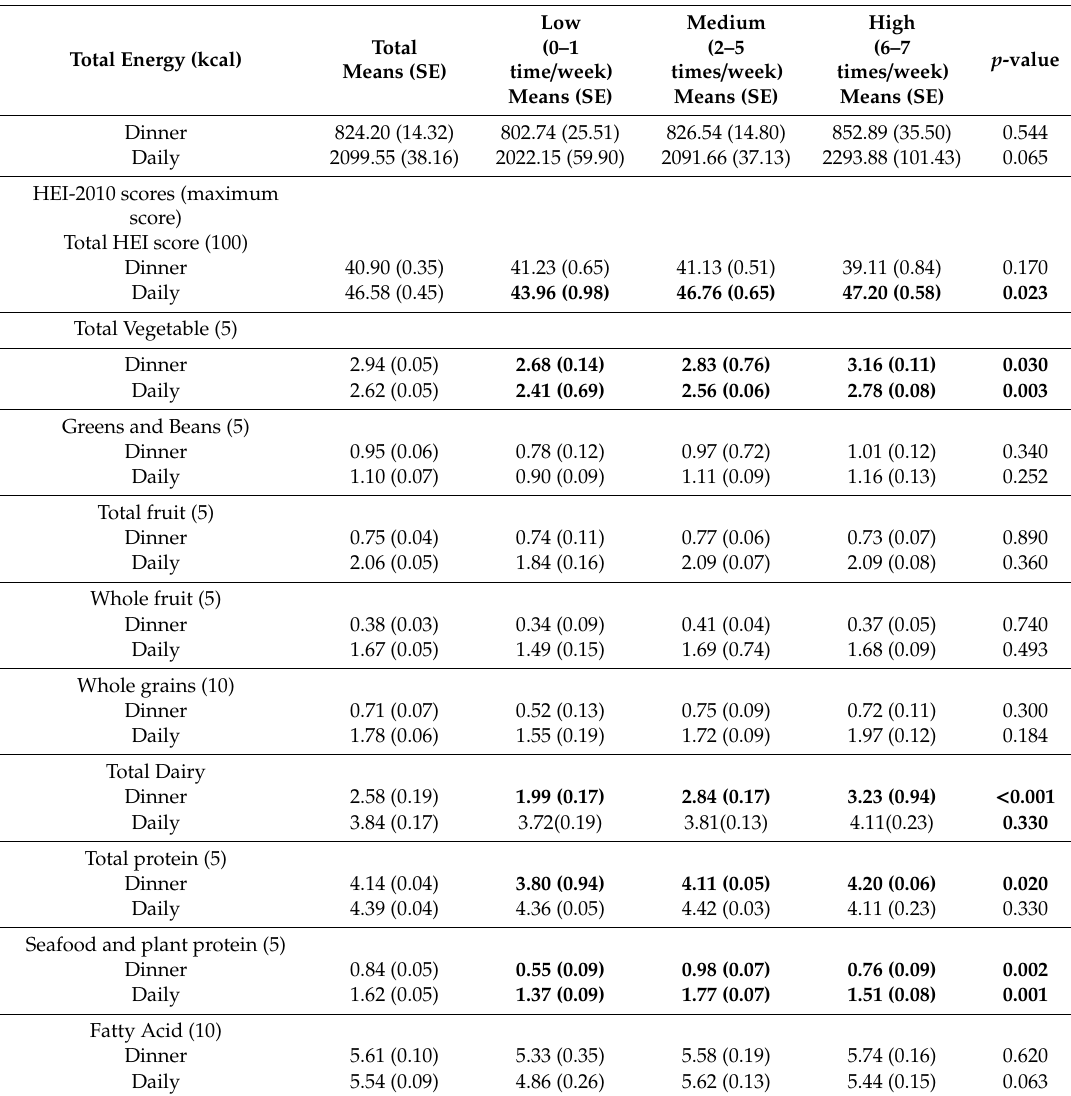
Table 3. Mean comparison of diet quality measures for dinner and daily intake (kcal, total HEI score, and HEI components) by cooking frequency categories, among Non-Hispanic Black adults ≥ 19 years of age: NHANES, 2007–2010 (for dinner data observations = 2027; weighted population = 22,883,113; for daily data observations = 2242; weighted population =